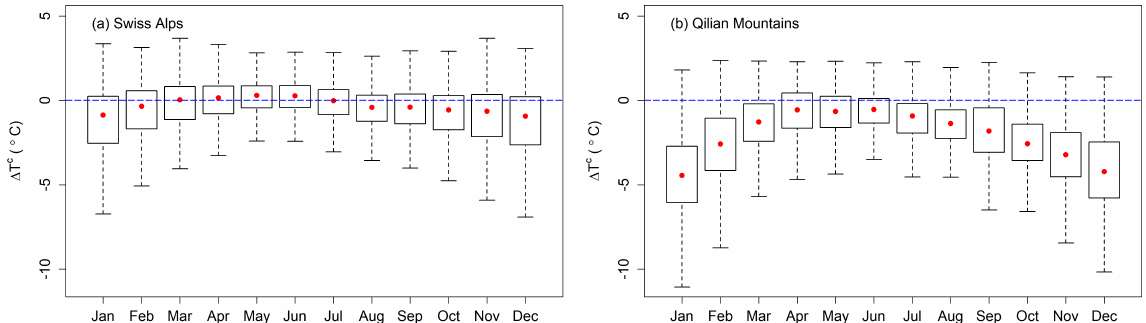
Figure 5. Seasonal changes shown as monthly distributions of average daily (cid:49)T c derived from ERA-Interim for the locations of all stations. Red dots are median